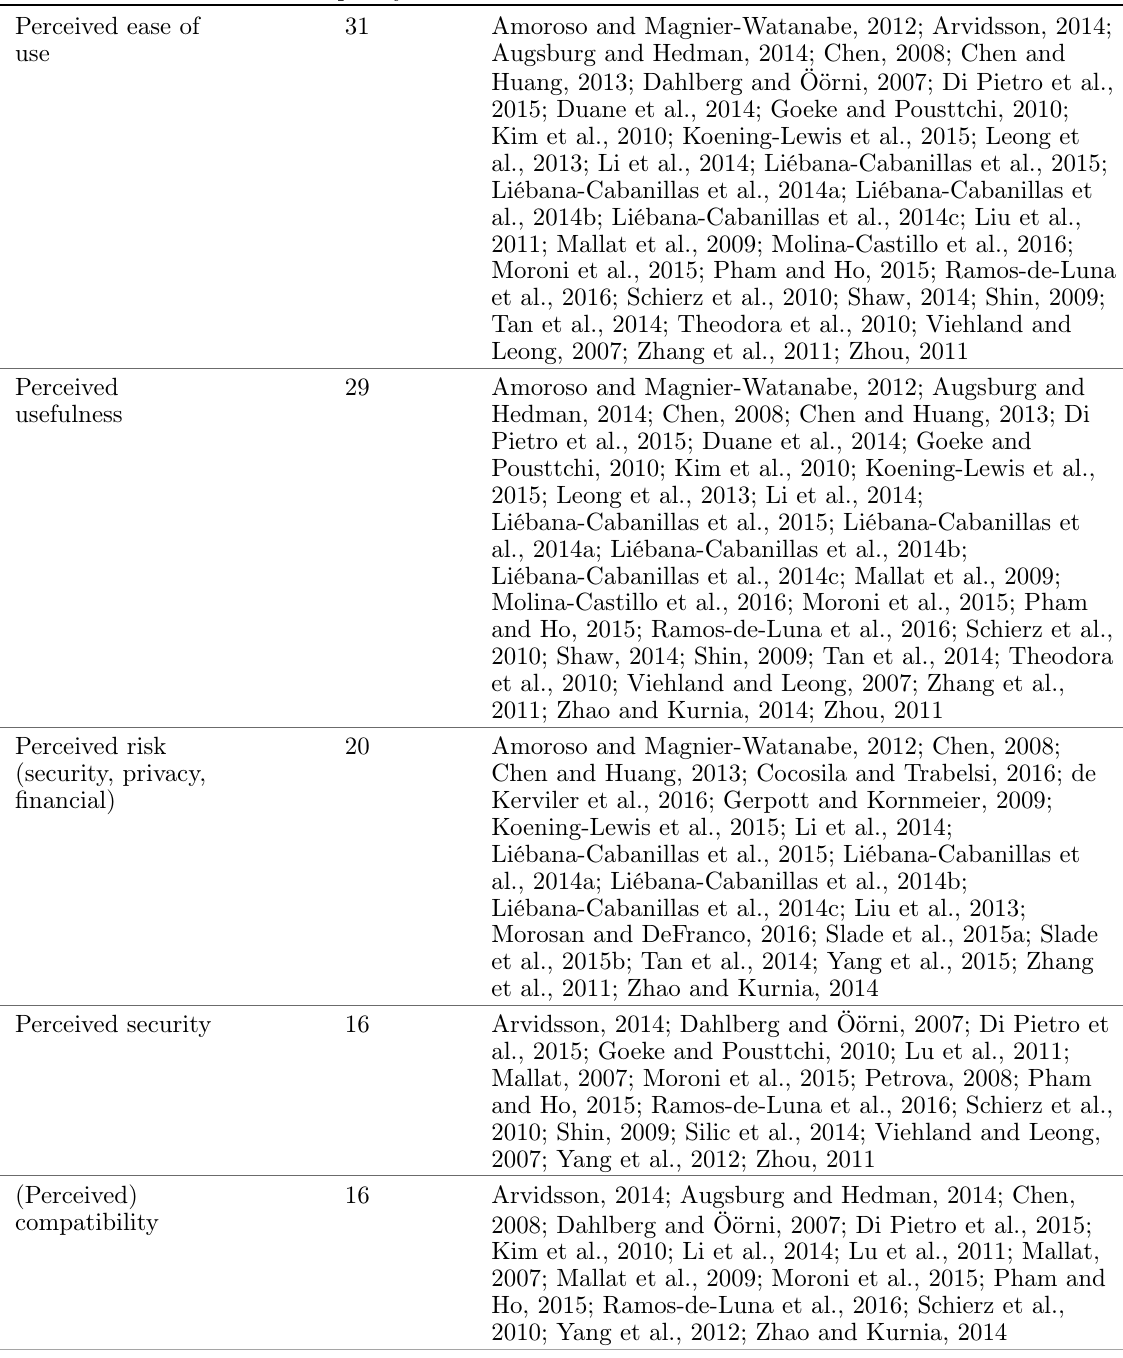
Table C.3. Constructs used in adoption studies related to service